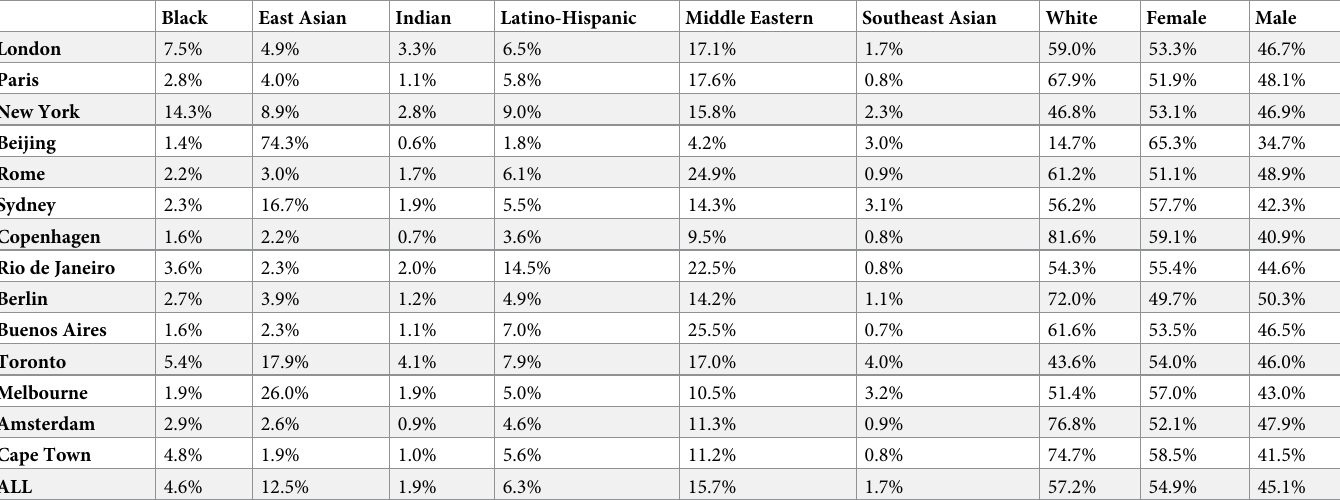
Table 2. Fraction of identified hosts of each majority ethnic group and gender appearance in the included cities, focusing on data for 2019. Black